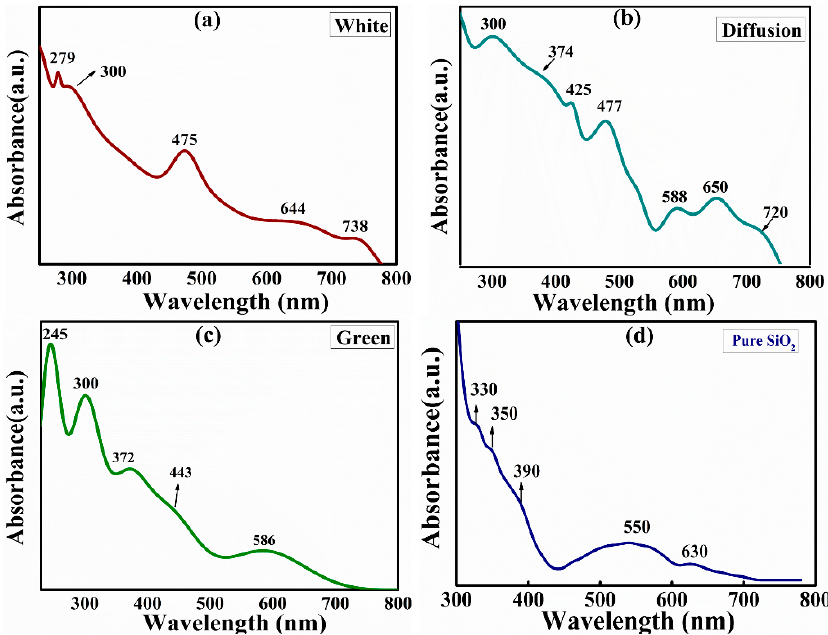
Figure 9. UV-VIS spectra of quartz-fluorite sample recorded for ( a ) white zone, ( b ) diffusion zone, ( c ) green zone, ( d ) and pure SiO 2 sample (CDH, New Delhi, 99.9% pure). green zone, ( d ) and pure SiO 2 sample (CDH, New Delhi, 99.9%